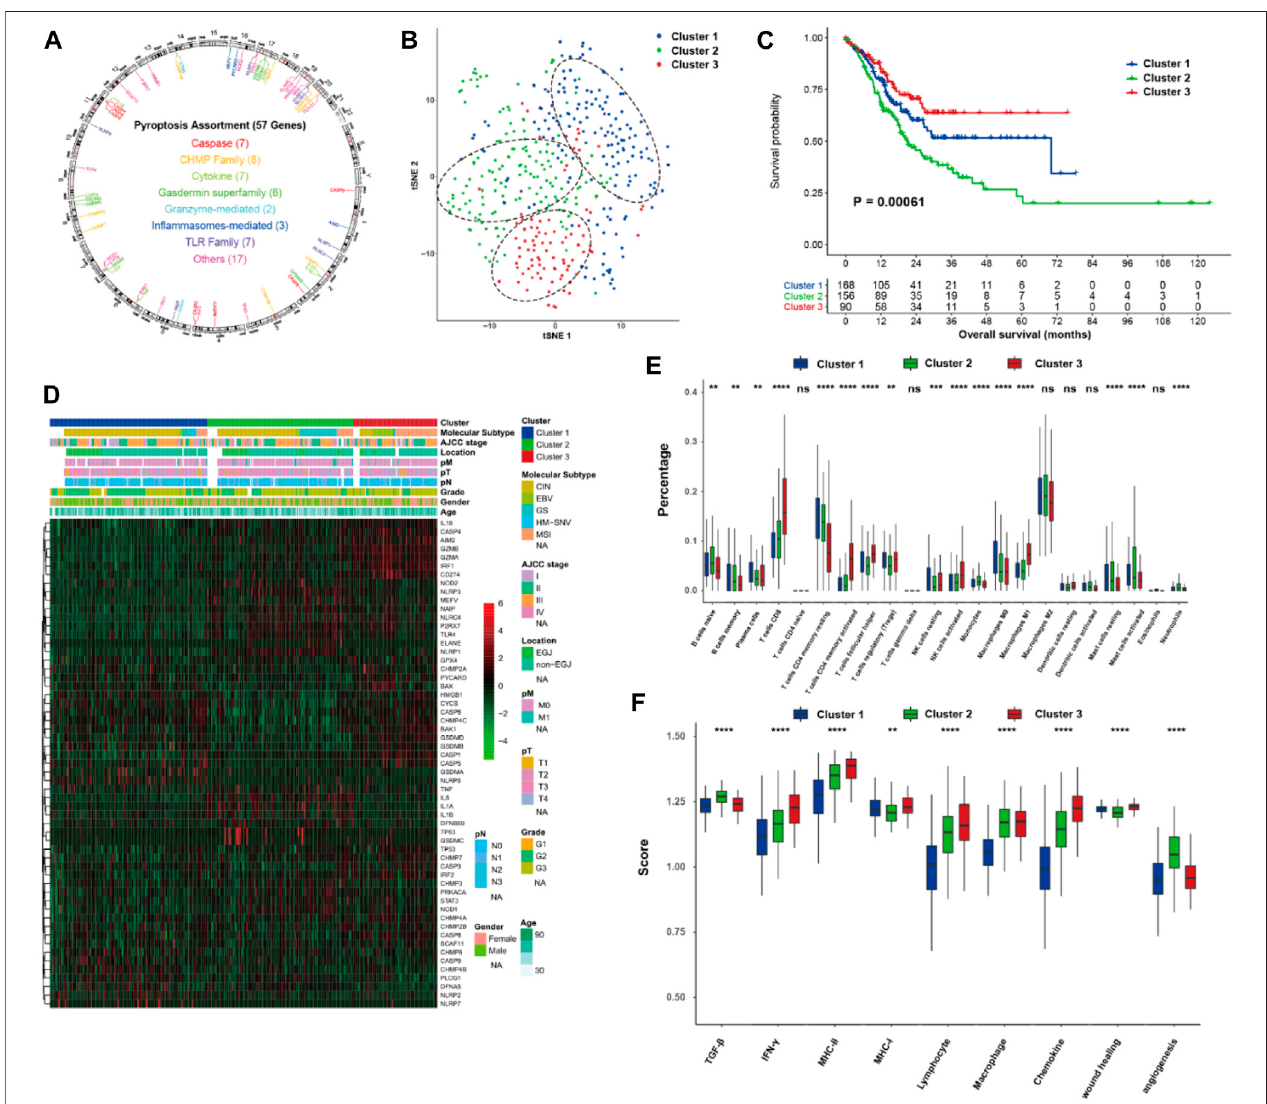
FIGURE 1| Pyroptosis-related molecularpatternswith tumor immunemicroenvironment ingastric cancer. (A) The location ofCNV of57 PRGs on chromosomes. (B) t-SNEofgastriccancerbasedonthemRNAexpression of57PRGs. (C) Kaplan-Meier curvesofoverallsurvivalofthethree pyroptosisclustersofgastric cancer. (D) Heatmapshowingthecorrelationsbetweenpyroptosisclustersandclinicopathologicalcharacteristics,andthemRNAexpressionof57PRGs. (E,F) proportionofthe22 immune cell fractions and immune signatures among the pyroptosis clusters. PRGs, pyroptosis-related genes; ns: not signi fi cant; * p < 0.05; ** p < 0.01; *** p < 0.001; **** p <